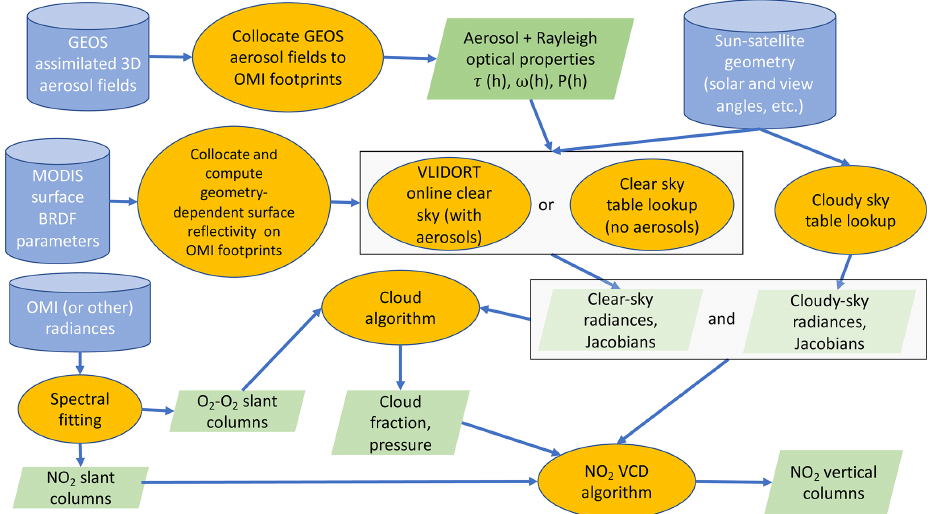
Figure 2. Flow diagram showing various steps and data used in our NO 2